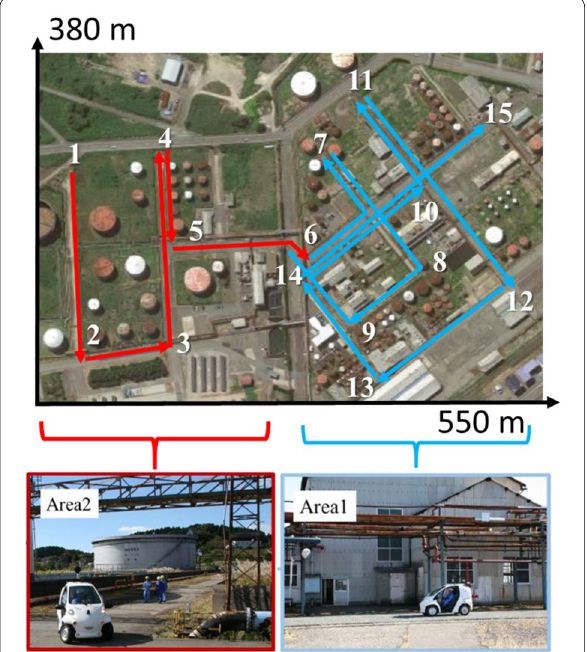
Fig. 3 Petrochemical complex environment. Area 1 (blue) features management and oil refinement buildings located near a road; Area 2 (red) shows an area of large oil tanks positioned sparsely for safety reasons